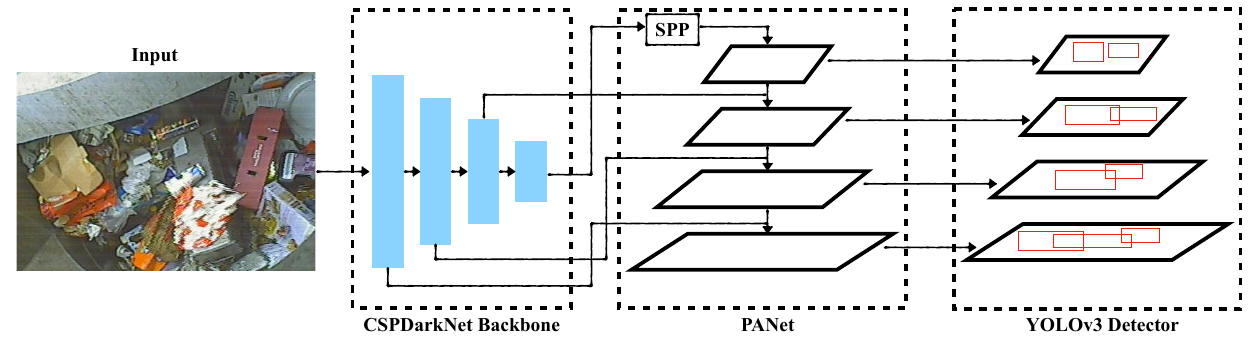
Figure 4. Overview of YOLOv4 architecture.